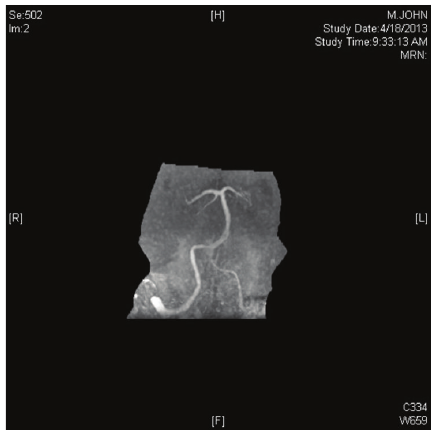
Figure 2: MRA of brain does not show any abnormality of vertebral arteries.